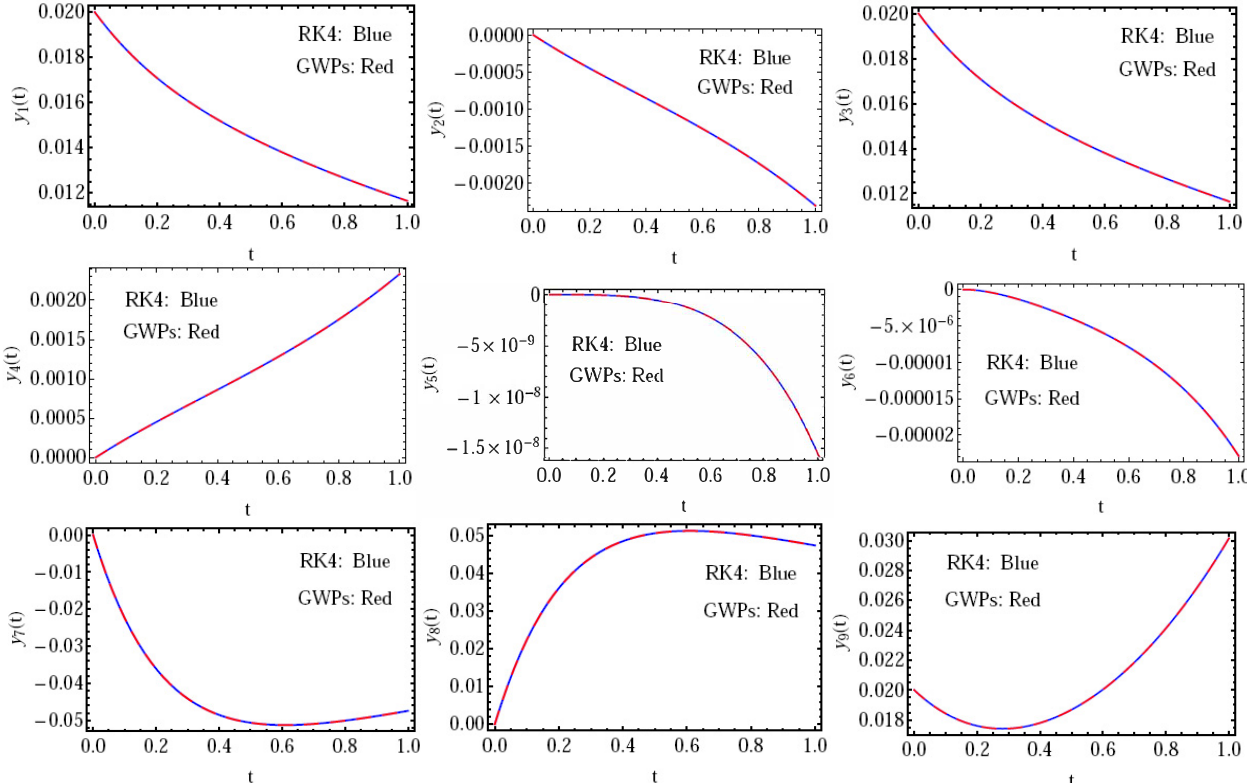
Figure 3. The solution y i ( t ) , i = 1 ( 1 ) 9 by GWPs and RK4 methods ν = 1.